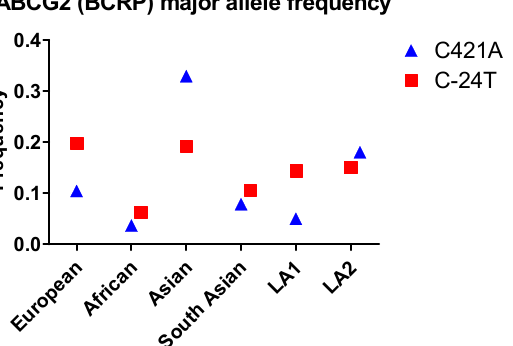
Figure 2. The allele frequency of ABCG2 in different populations. Asian: All Asian individuals excluding South Asians; LA1: Latin American individuals with Afro-Caribbean ancestry; LA2: Latin American individuals with mostly European and Native American Ancestry. Data were extracted from NCBI ALFA project (version: 20200227123210, www.ncbi.nlm.nih.gov/snp/docs/gsr/alfa/ [17]).